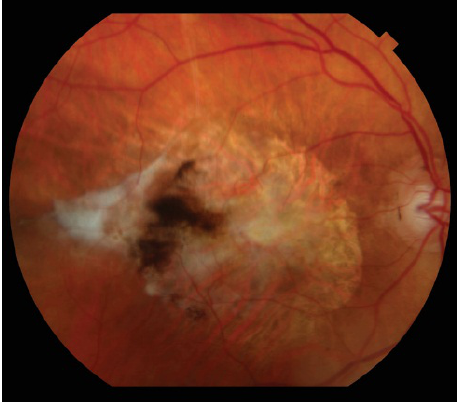
Figure 4. Neovascular age-related macular degeneration can also present with significant retinal hemorrhage.